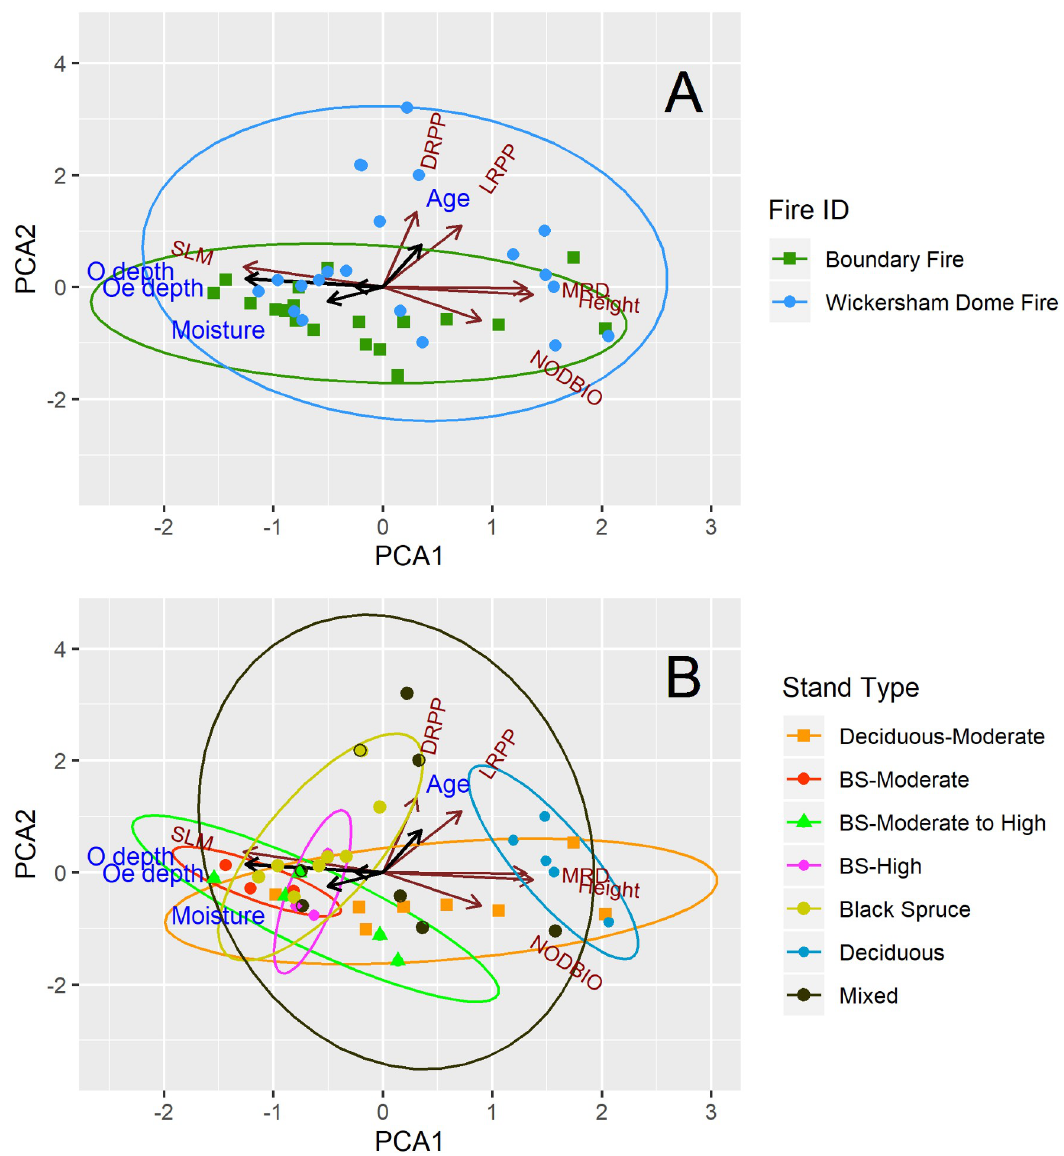
Fig 3. Principal component analysis (PCA) of Siberian alder growth traits: Plant-level live nodule biomass (NODBIO), mean ramet height (Height), mean ramet diameter (MRD), specific leaf mass (SLM), live ramets per plant (LRPP), and dead ramets per plant (DRPP). The PCA is displayed by burn scar (A) and by stand type within each burn scar (B). Brown arrows and labels represent the orientation of Siberian alder growth traits used in the PCA. Ellipses represent the 95% confidence interval for each burn scar or stand type. Black arrows with associated blue labels symbolize the important predictor variables of each PCA axis as determined by AICc best model subset for both burn scars: Moisture = moisture in organic horizon, O depth = depth of organic horizon, Oe depth = depth of hemic layer, Age = post-fire